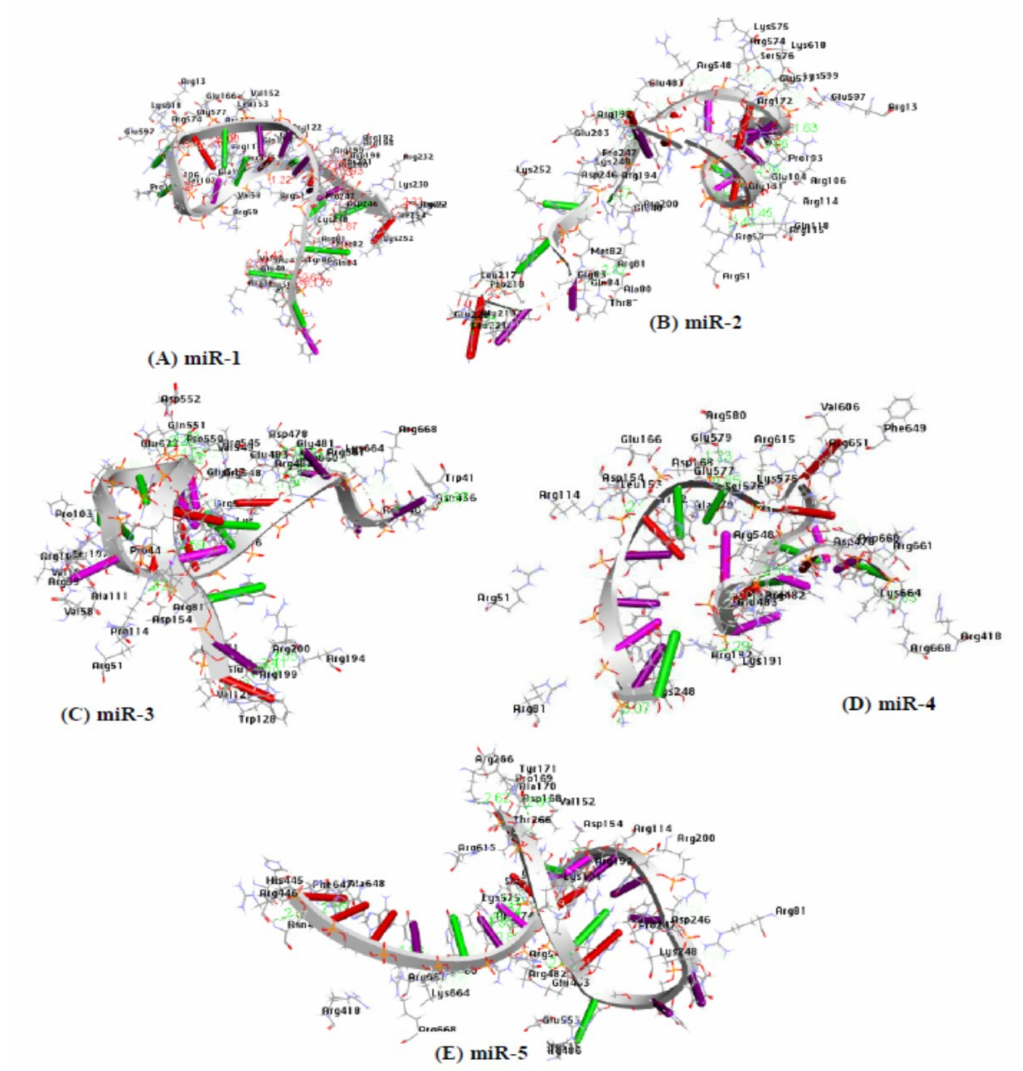
Figure 7. The amino acid residues of Argonaute protein participating in the interaction with each of the five candidate microRNAs within a distance of 3.5 Å are deciphered, respectively. ( A ) amino acids participating in miR-1-Agonaute protein duplex, ( B ) amino acids participating in mir-2-Agonaute protein duplex, ( C ) amino acids participating in mir-3-Agonaute protein duplex, ( D ) amino acids participating in mir-4-Agonaute protein duplex, and ( E ) amino acids participating in mir-5-Agonaute protein